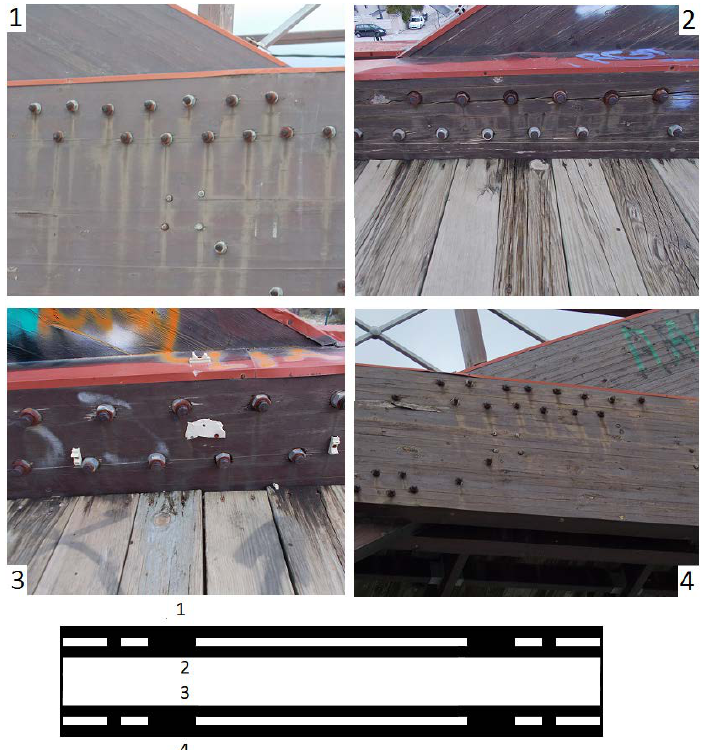
Figure 4. Photos of connections of the bridge deck with the west part of the arch. Location of photos marked 1 to 4 corresponds to connections of the deck with the arch in areas marked with numbers in the deck map at the bottom of the figure (corresponding to Figure 1c). Photos taken in 2012, indicate asymmetric damage (longitudinal splitting cracks), of higher amplitude and frequency along the south sides (2, 4) of the deck beams. A similar situation was also observed in the east side of the deck.